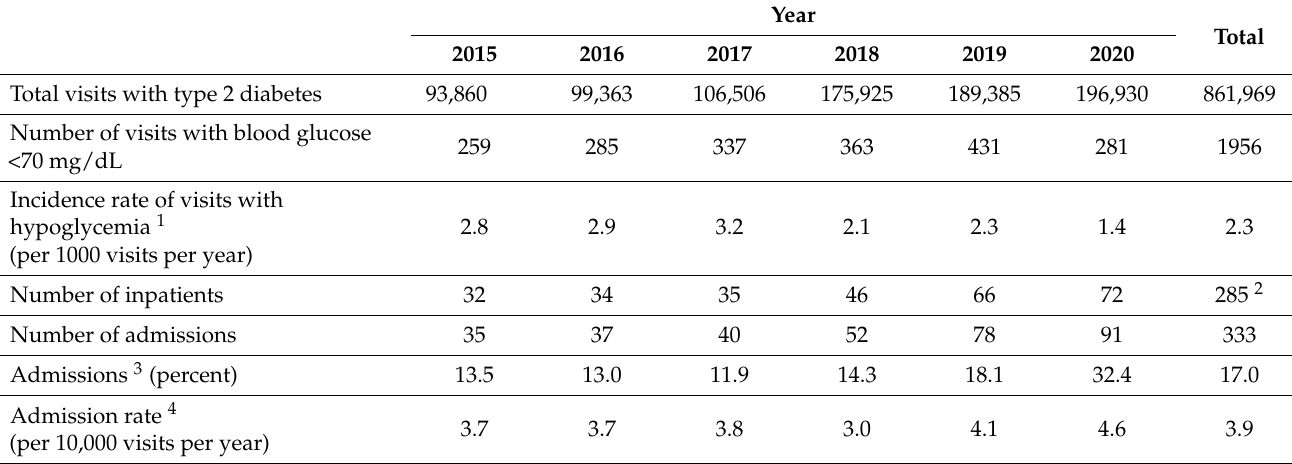
Table 1. Healthcare resource use and incidence